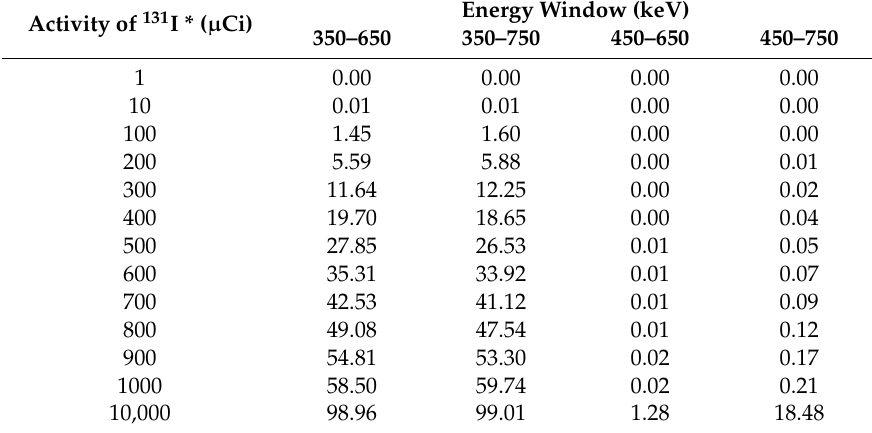
Figure 4. 131 I prompt emission fraction within various energy windows. ( A ) Activity of 131 I was set to 0 to 1000 µCi in steps of 100 µCi with 100 µCi 18 F activity. ( B ) 10 µCi of 131 I with 100 µCi of 18 F. ( C ) 300 µCi of 131 I with 100 µCi of 18 F ( D ) 131 I prompt emission fraction within 350–650 keV at the level of 100 µCi of 18 F. To correct 131 I prompt emission, we applied our developed 131 I prompt emission-correction method to both a phantom and an in vivo mouse lymphoma model. Figure 5A shows the representative PET image of NEMA NU4-2008 image quality phantom and Figure 5B shows the SOR results compared with the gold standard ( 18 F-FDG), before 131 I prompt emission and after 131 I prompt emission. SOR was 13.7% for 18 F-FDG PET. After administration of 131 I, SOR was 16.9% and 14.4% before and after 131 I prompt emission correction, respectively. The percentage difference was <5% between 18 F-FDG only and after 131 I prompt emission-correction. When our 131 I prompt emission-correction method was applied to the in vivo mouse model (shown in Figure 5C), the SUV of the tumor region was 2.74 ± 0.13 for 18 F-FDG PET only, 2.97 ± 0.18 after 131 I prompt emission-correction, and 3.78 ± 0.2 before 131 I prompt emission-correction (shown in Figure 5D. Contrast was improved by 18% after 131 I prompt emission-correction. Before 131 I prompt emission-correction, SUV was overestimated by 38% (* p < 0.05). However, there was no statistically significant difference between SUV for 18 F-FDG and after correction of 131 I prompt emission.